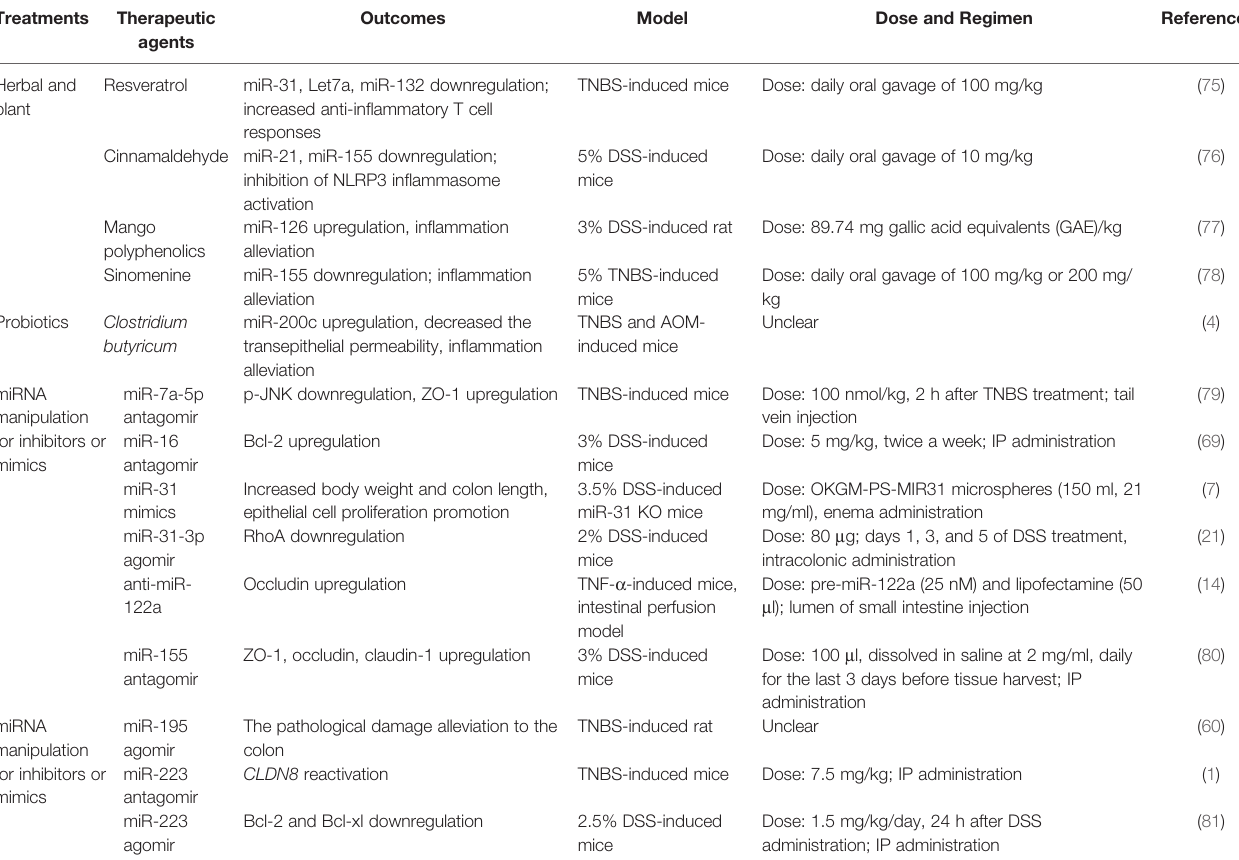
TABLE 3 | Some bene fi cial therapeutic agents through targeting abnormal miRNA in IBD models (mice and rats).